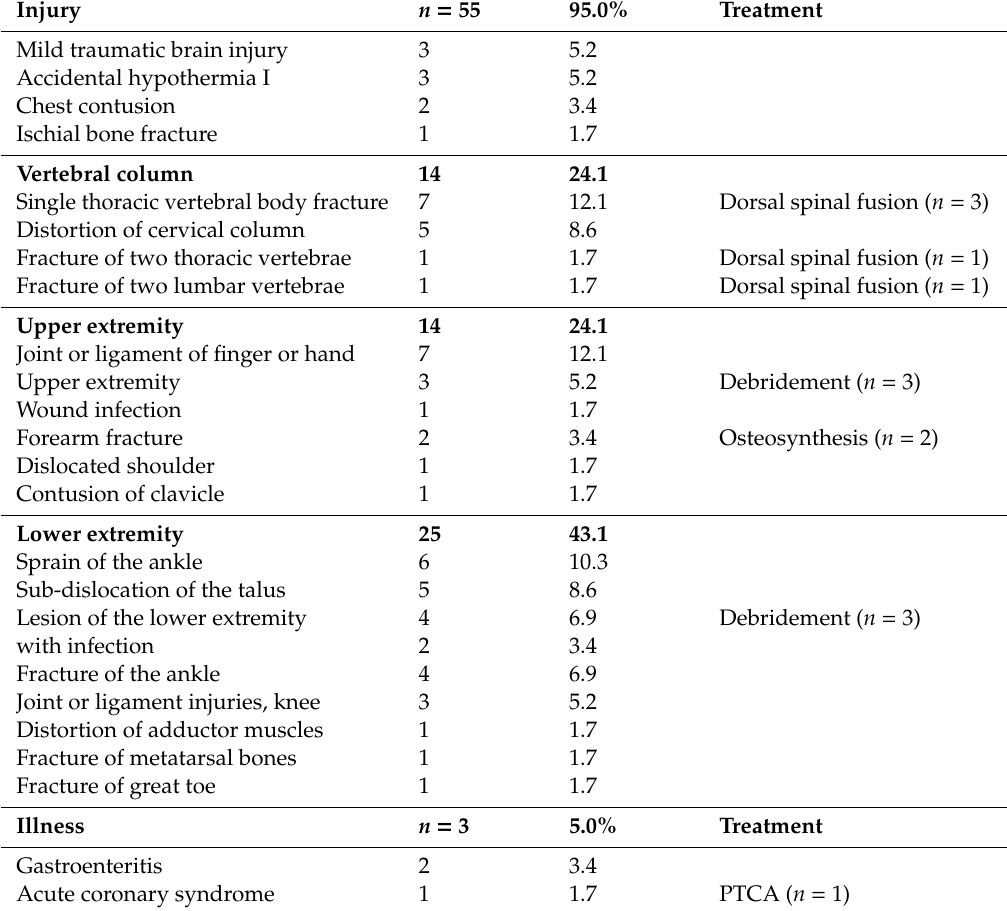
Table 6. Injured patients involved in canyoning emergencies treated at Innsbruck Medical University Hospital from November 1, 2005 to October 31,